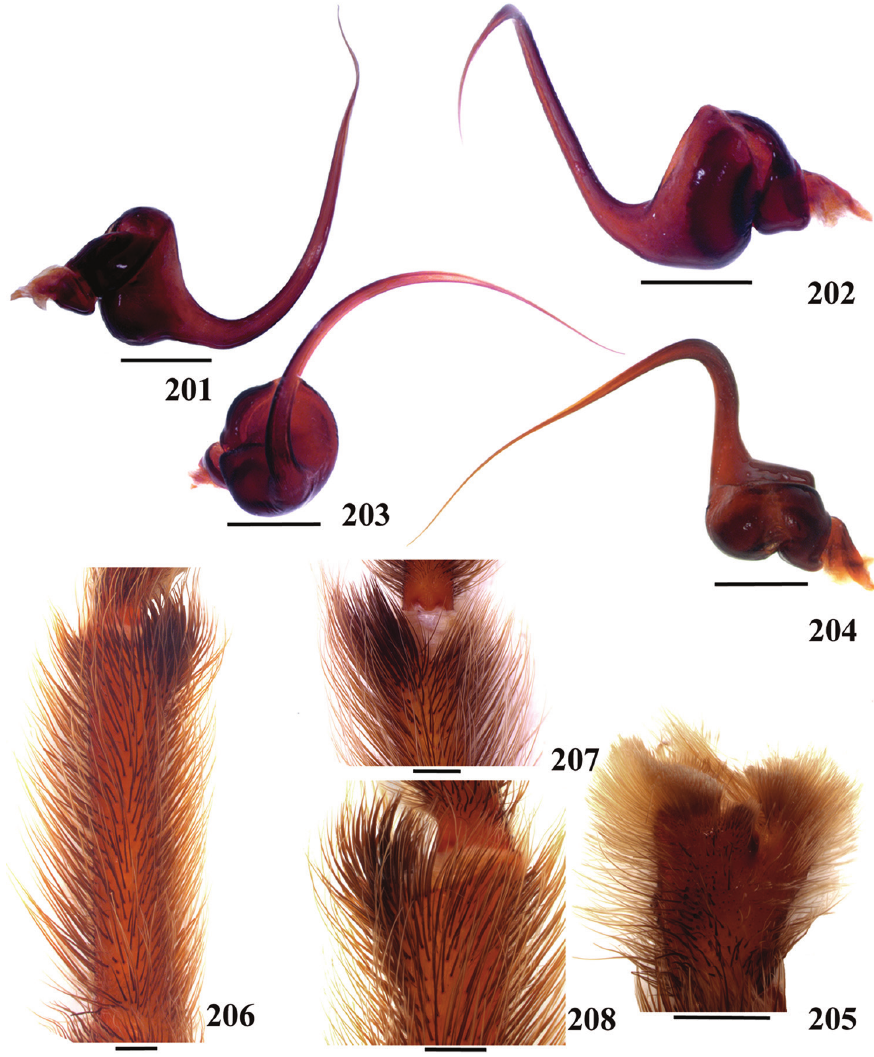
Chelicera: basal segment with 12 teeth and some small teeth on promargin. Ster- num: 6.0 long, 3.91 wide. Sigilla: three pairs, anterior rounded, middle fusiform, pos- terior rounded, set at 45°angle, all close to margin. Legs: Formula: IV=I II III. Length leg IV to leg I: 1.09. Clavate trichobothria: distal 2/3 tarsi I–IV. Scopula: Tarsi I–IV fully scopulate. Metatarsi I–II fully scopulate; III 1/2, IV 1/5 distal scopulate. IV divided by a bald